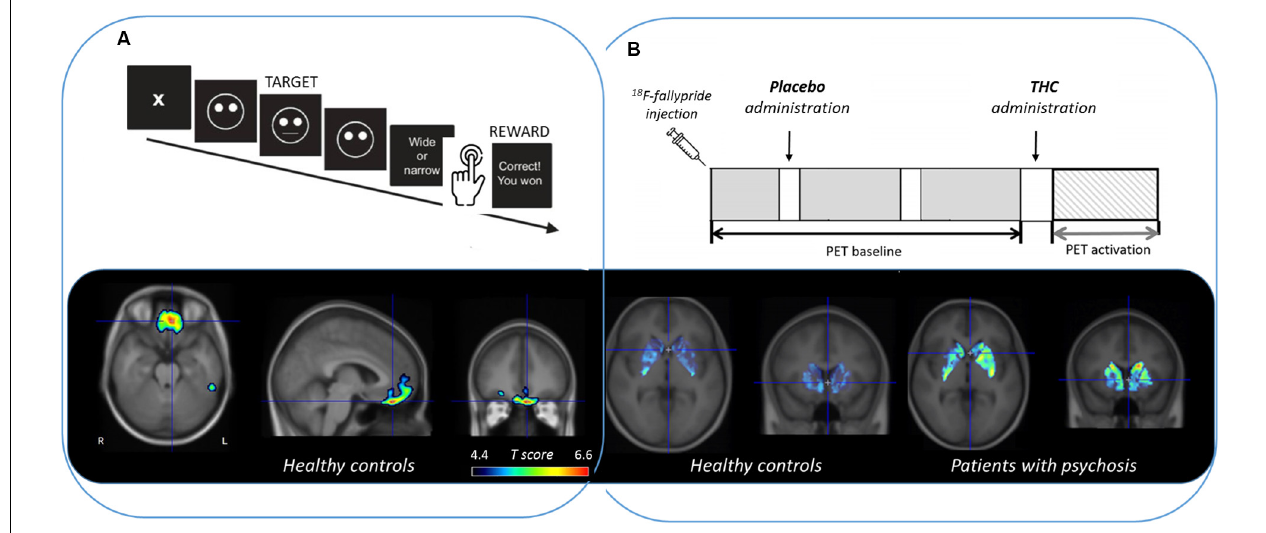
FIGURE 1 | Extrastriatal and striatal dopamine release measured with 18 F-fallypride PET and quantified with LSRRM (reported as a statistical parametric t map based on the significance of γ ) during (A) a reward responsiveness learning task in healthy controls (Ceccarini et al., 2012) and (B) (cid:49) 9 -THC (the main psychoactive ingredient of cannabis) administration in healthy controls compared to patients with psychosis (Kuepper et al., 2013).